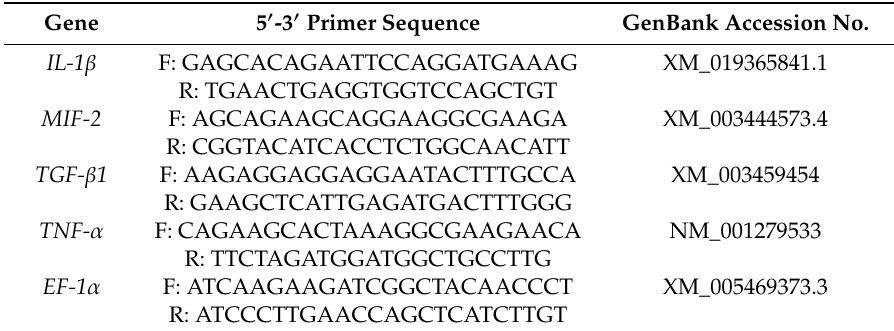
Table 2. Primers designed in the